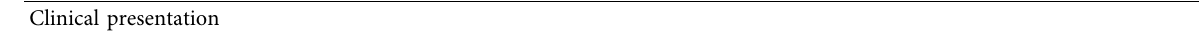
Table 3: Summary of